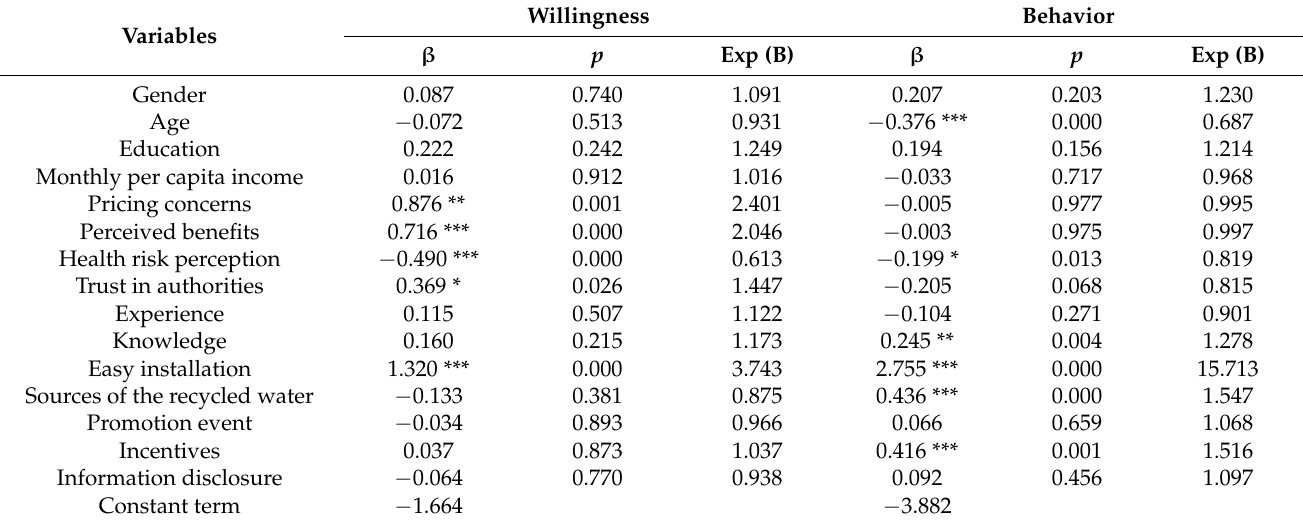
Table 3. Factors influencing the willingness and behavior of using recycled water for flushing.